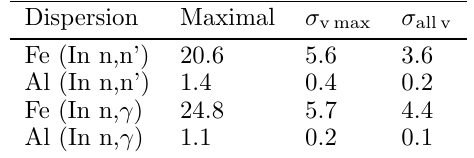
Table 1. Indium (n,n’) and (n, γ ) reaction rate dispersion in percents due to iron and aluminium for 32 ACE